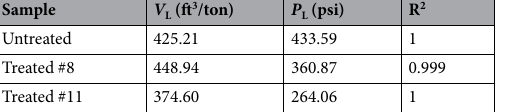
Table 5. Langmuir parameters for untreated and bioconverted coals.